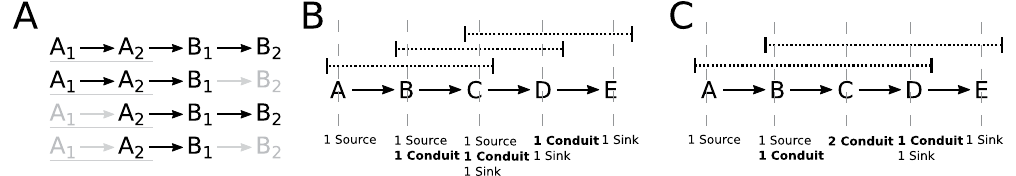
Figure 1. Strategy used to avoid double counting flows. ( A ) Four chunks matching to the same country-level chain ( A | B ) originated from the same GCOC ( A 1 | A 2 | B 1 | B 2 ). Companies present in the original chain but not in the chunk are depicted in gray. The upstream of the chunks is underlined. B 1 corresponds to the first owner in country B . ( B , C ) Finding conduits using overlapping chains. A,B,C,D and E are individual countries. ( B ) Conduits would be counted only once after splitting the chain in chunks of size three and counting all the fragments. ( C ) Conduits would be double counted if the chain is split in chunks of size